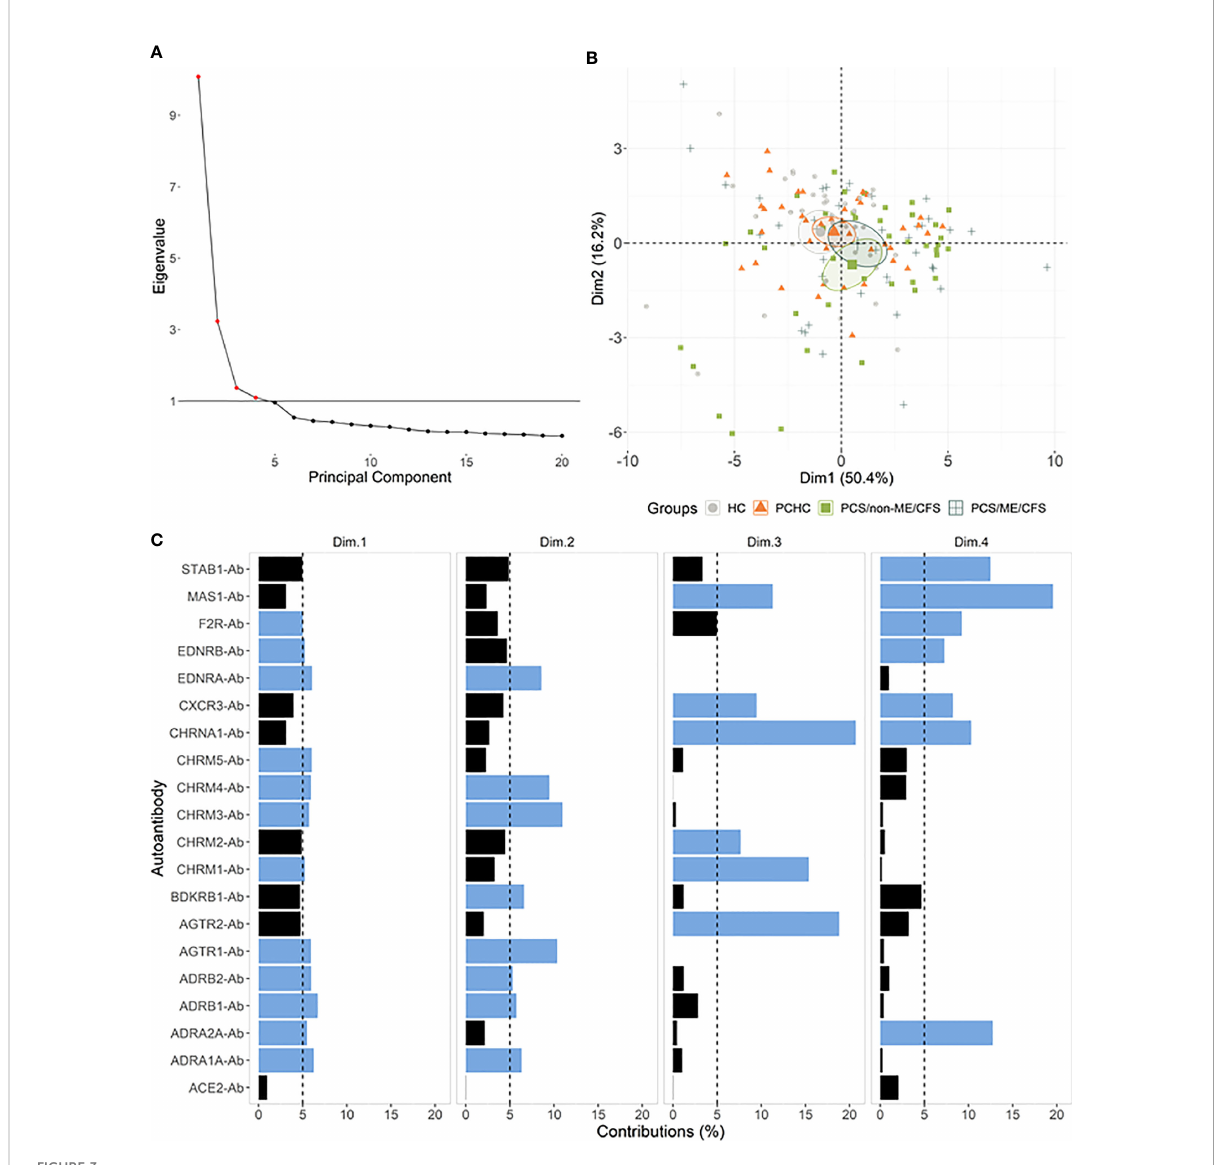
FIGURE 3 Autoantibodies (-Ab) stratify patients by post-acute COVID-19 outcomes. (A) Principal component analysis (PCA) with spectral decomposition based on logarithmic values of 20 Abs show the strati fi cation of the four studied groups. Variables pointing to the same sense of the corresponding principal components are positive correlated. Small ellipses are the concentration around the mean points of each group. (B) Graphs of variables (Abs) obtained by PCA of all individuals in this study. (C) Barplot with the contribution percentages of each variable to each dimension. A black dashed line is plotted on the 5% mark, and blue bars indicate a contribution higher than